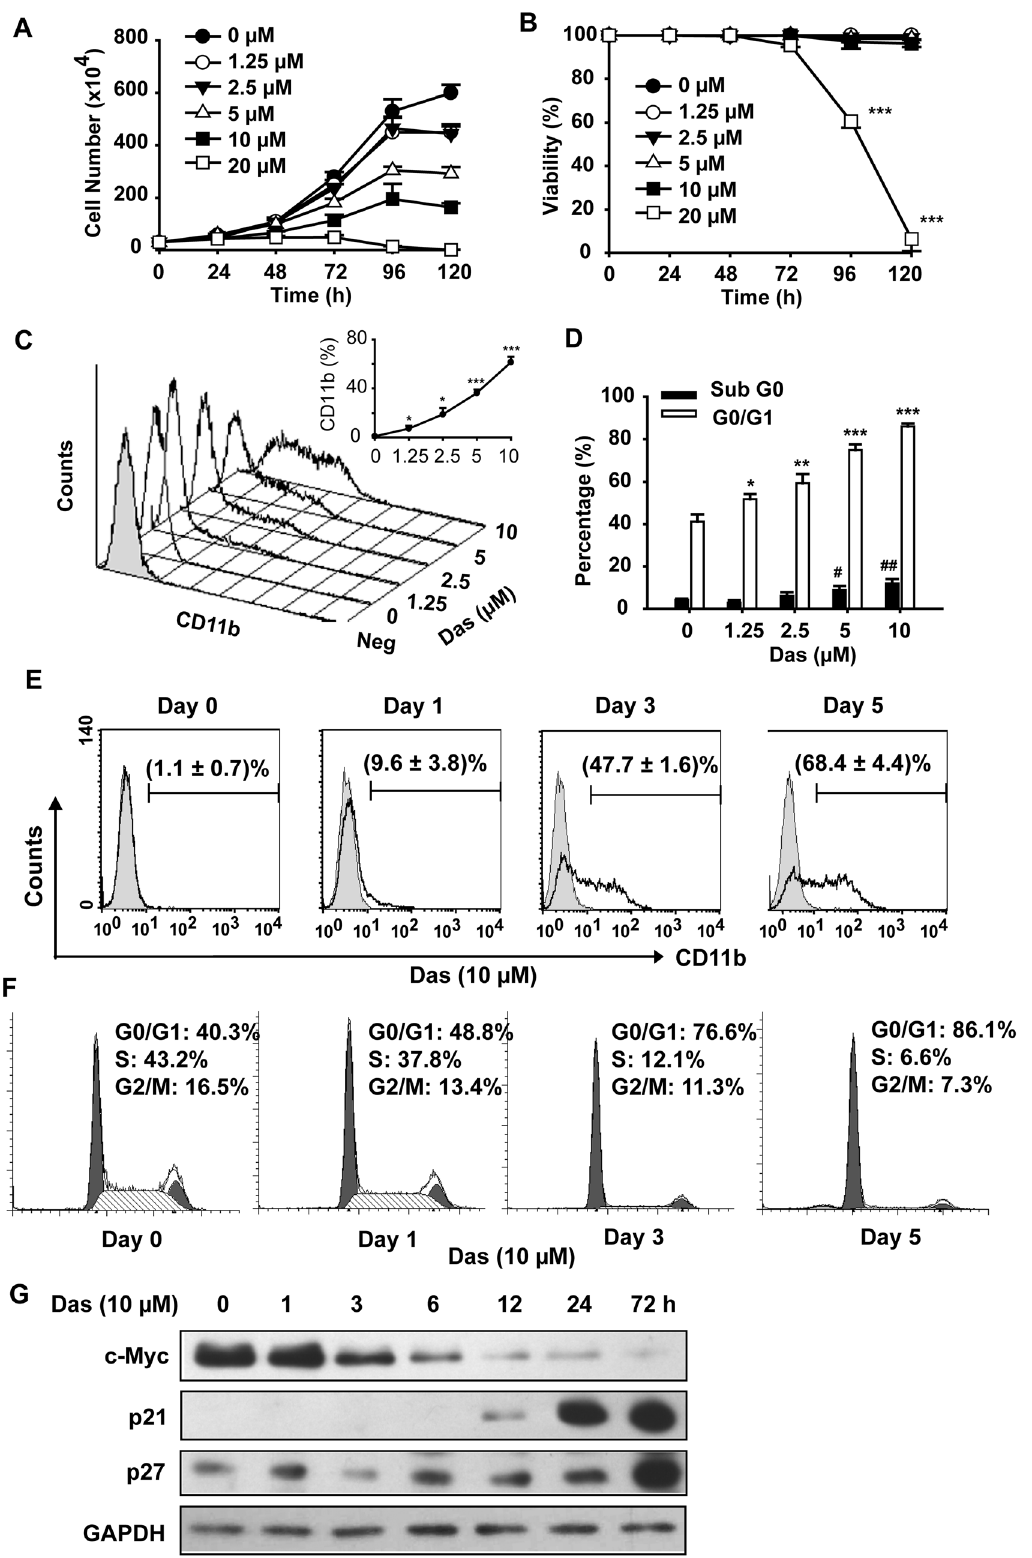
Figure 1. Dasatinib exhibits dose- and time-dependent effect on inducing differentiation of HL60 cells. HL60 cells were treated with dasatinib for the indicated times. Aliquots of the cultures were withdrawn at each time point and subjected to manual counting, following trypan blue staining for determination of (A) the total number of viable cells and (B) the percentage of viable cells. Data presented are the mean 6 SD of cell numbers from triplicate wells. The experiments were repeated twice. *** P , .001 versus vehicle treated cells. (C) and (E) The percentages of CD11b